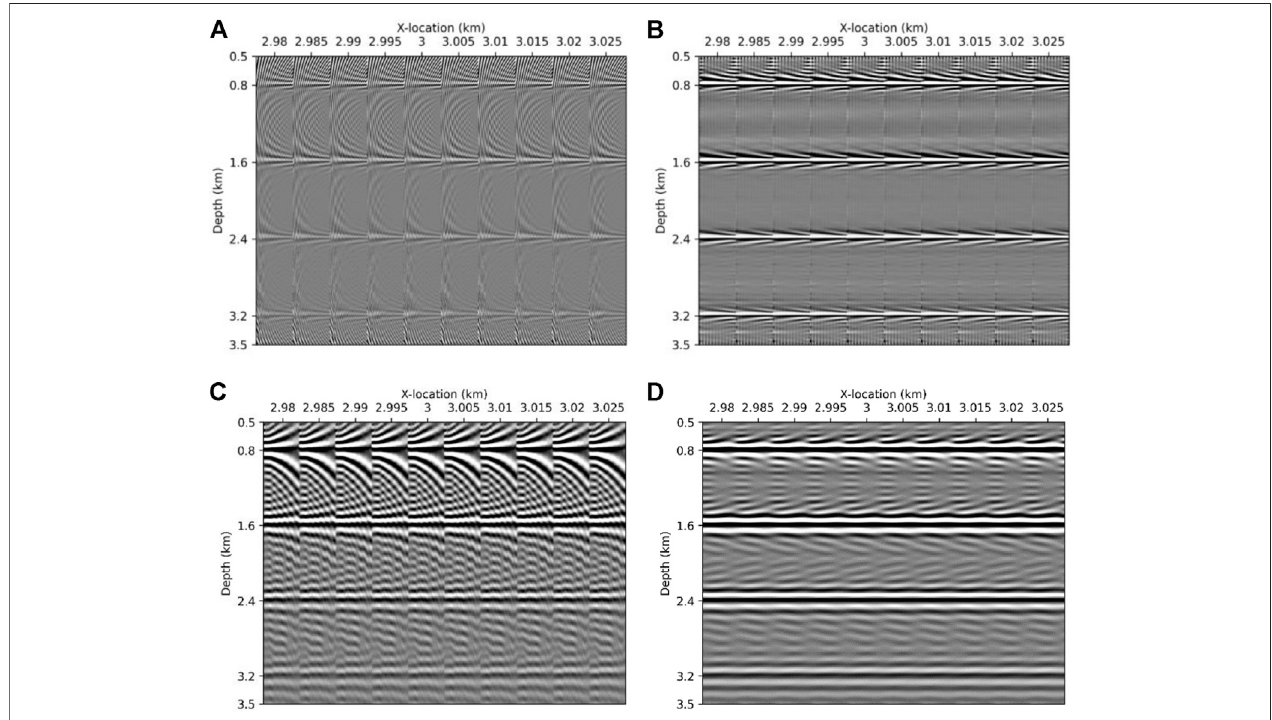
FIGURE 3 | Migration image of (A) smoothed true model, (B) smoothed and increased velocity in 2nd and 4th layer model, and (C) smoothed and decreased velocity in 2nd and 4th velocity layer model.